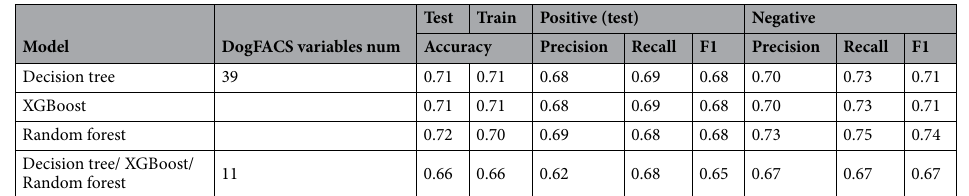
Table 2. Classifier performance comparison.